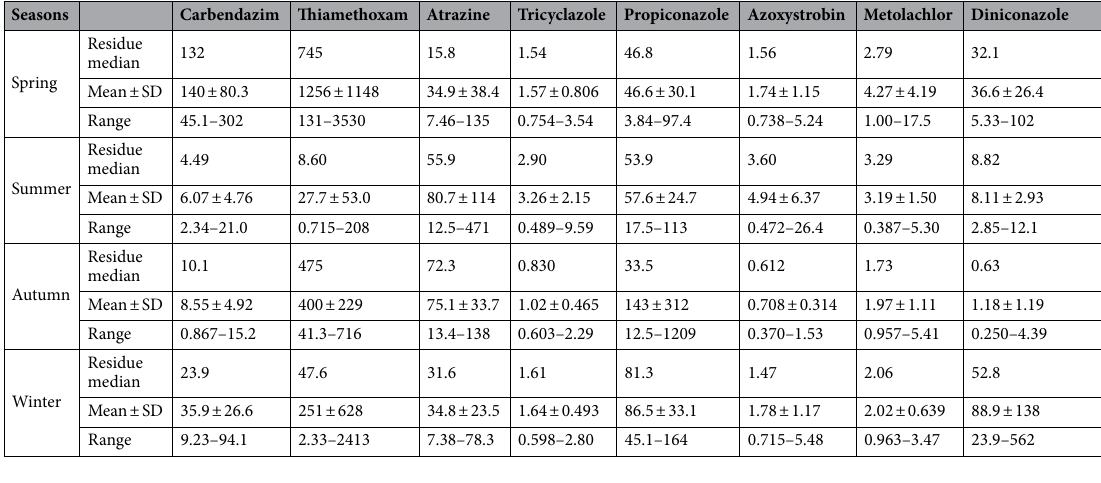
Table 1. The residue level of eight pesticides in surface waters at 13 sampling positions in the four seasons. They were in the ranges of 0.867–302 ng/L (carbendazim), 0.715–3530 ng/L (thiamethoxam), 7.38–471 ng/L (atrazine), 0.489–9.59 ng/L (tricyclazole), 3.84–1209 ng/L (propiconazole), 0.370–26.4 ng/L (azoxystrobin), 0.387–17.5 ng/L (metolachlor), 0.250–562 ng/L (diniconazole), respectively.